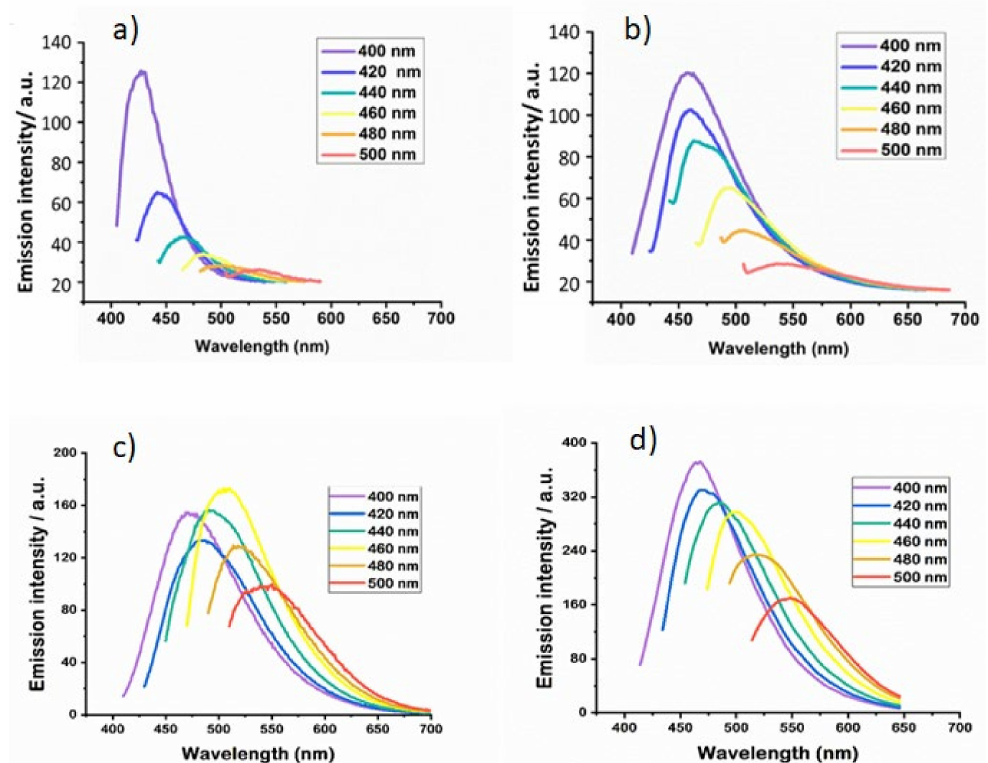
Figure 3. ( a ) Emission spectrum of Cu-SiQDs, using two Cu dopants per SiQD, at different exciting wavelengths (400–500 nm in 20-nm increments). ( b ) The emission spectrum of Cu-SiQDs, using four Cu dopants per SiQD at different exciting wavelengths (400–500 nm). ( c ) The emission spectrum of Sc-SiQDs at different excitation wavelengths (400–520 nm). ( d ) The emission spectrum of Zn-SiQDs at different exciting wavelengths (320–600